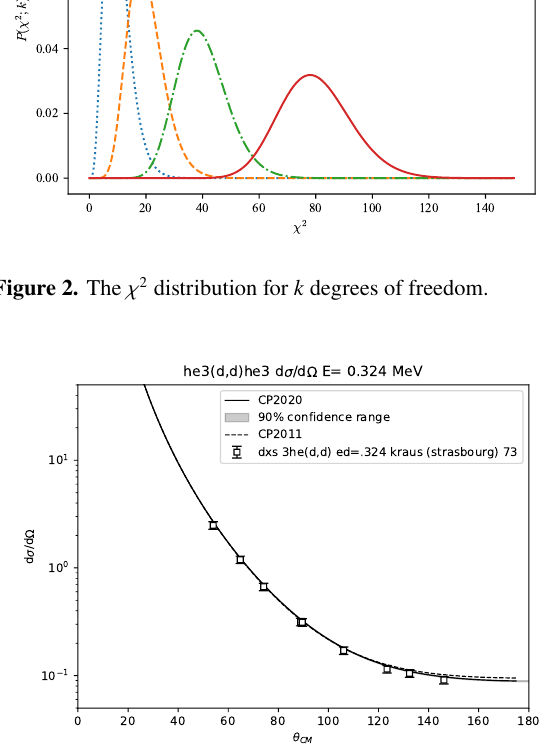
Figure 3. The angular distribution for 3 He( d , d ) 3 He for deuteron incident laboratory energy 324 keV of the unpolarized differential cross section in the center of mass as a function of the center of mass angle θ cm . The evaluation is shown by the solid curve. The gray band is the 90% confidence interval determined as described in the